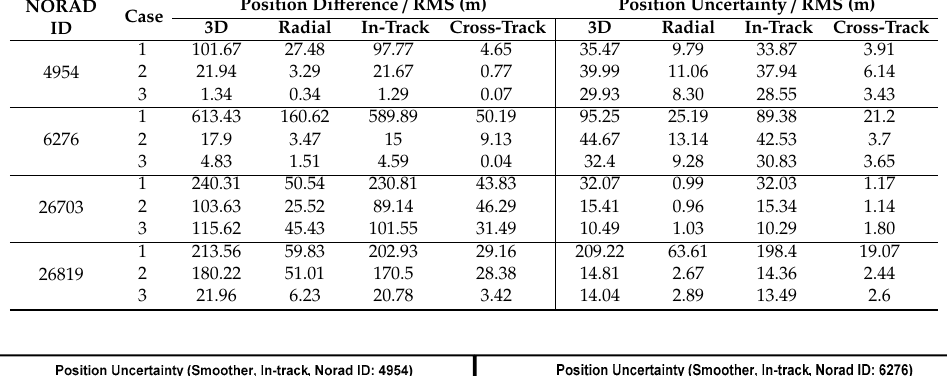
Table 9 . The 3D position difference RMS and 3D position uncertainty RMS of Case 1, 2 and 3.